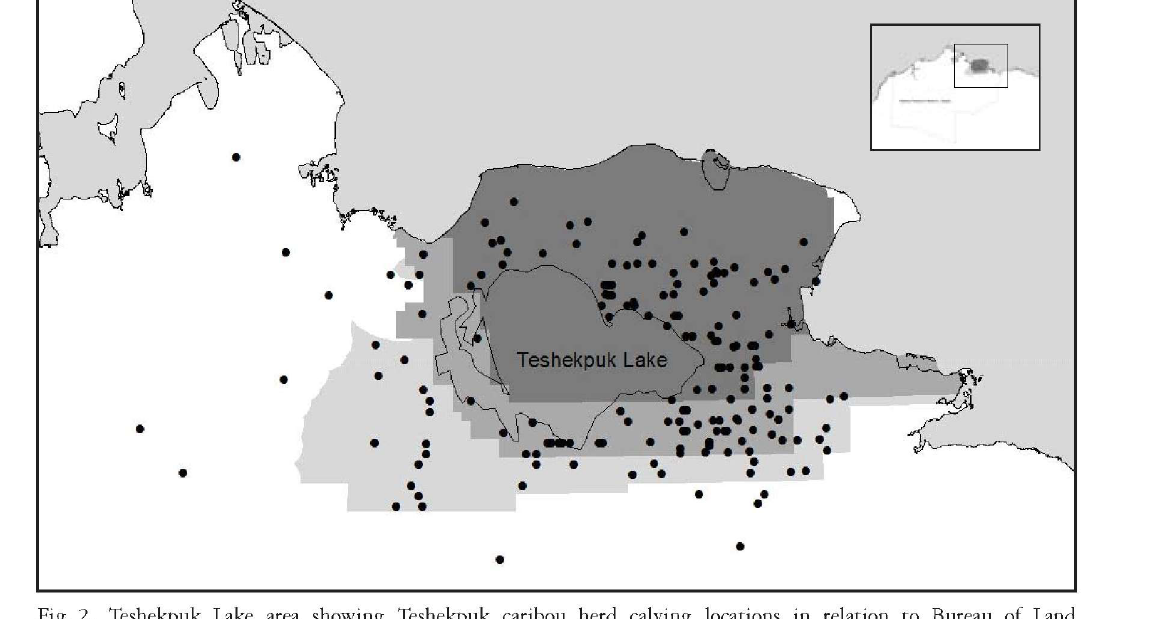
Fig. 2. Teshekpuk Lake area showing Teshekpuk caribou herd calving locations in relation to Bureau of Land Management Environmental Impact Statement protective boundaries from 1994 to 2003 (see Fig. 1). Note, there are 2 calving locations located farther west that are not shown on this close-up. a paired /-test, and movement rates of cows that were seen with a calf versus cows that were not with an unpaired t-test (Zar,